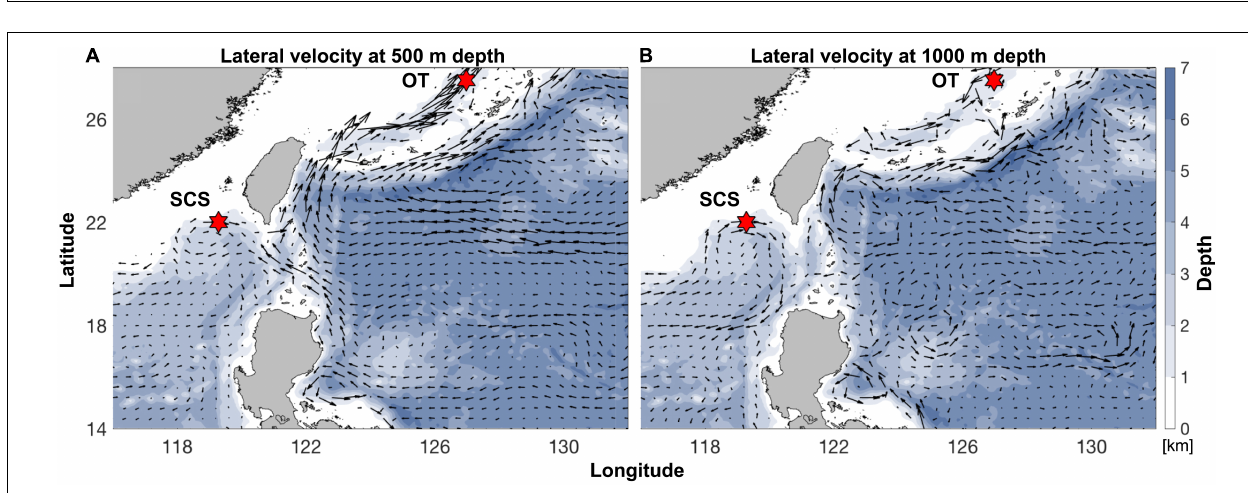
FIGURE 4 | Population structure analyses based on ADMIXUTRE (A,C) and PCA (B,D) using entire SNP for (A,B) and the outlier SNP dataset for (C,D) , showing the population genetic structure of S. crosnieri (K for optimal genetic group number).